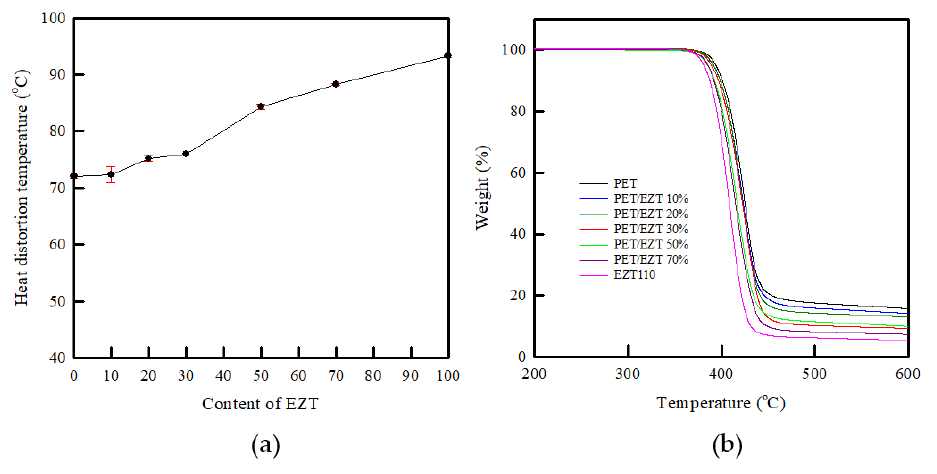
Figure 4. ( a ) HDT and ( b ) TGA curves of the PET/EZT samples. Table 2. HDT and degradation temperature of the PET/EZT samples. Table 2. HDT and degradation temperature of the PET/EZT